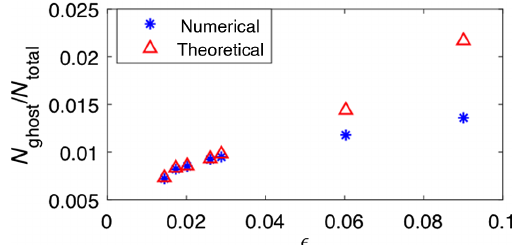
FIG. 7. The ratio between the number of ghost excitations N over the total number of waves N ghost nonlinearity. Values given by numerical simulations (blue) are compared with the theoretical predictions (red) given by Eq. (27). a Þ t Þi t j as k ð